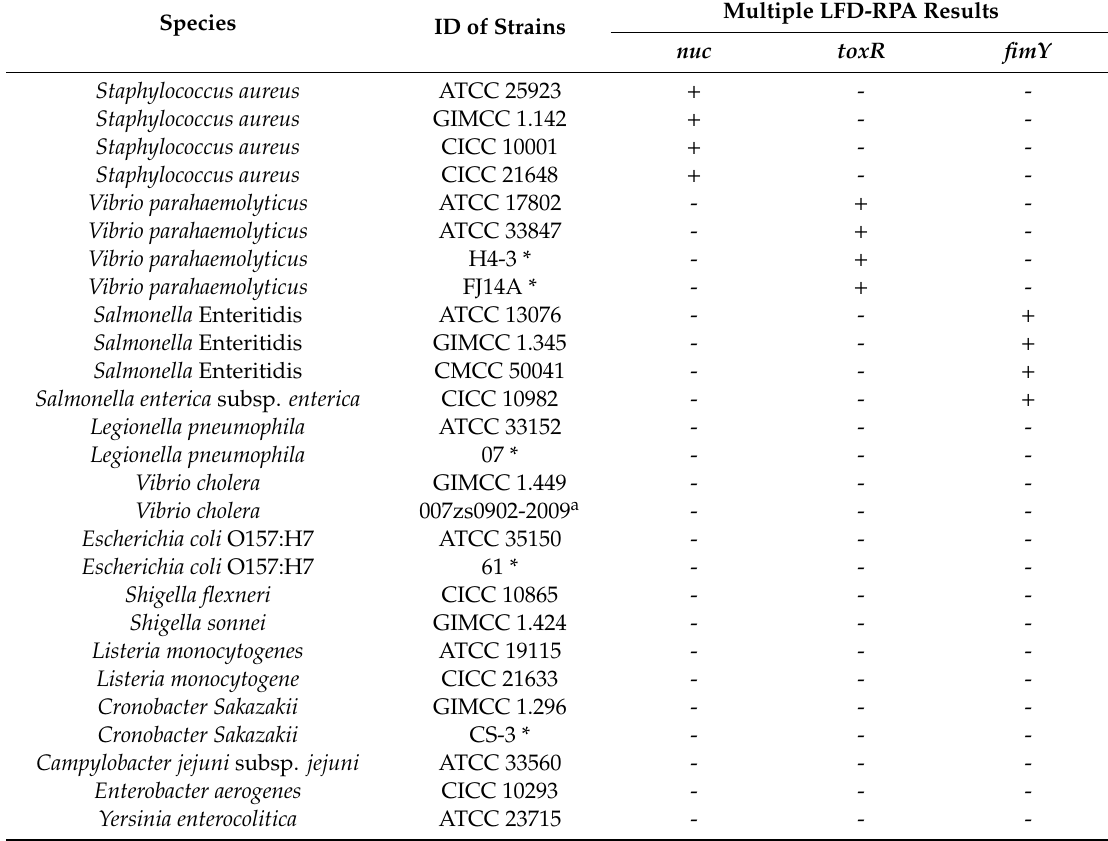
Table 1. Information of bacterial strains used for specificity